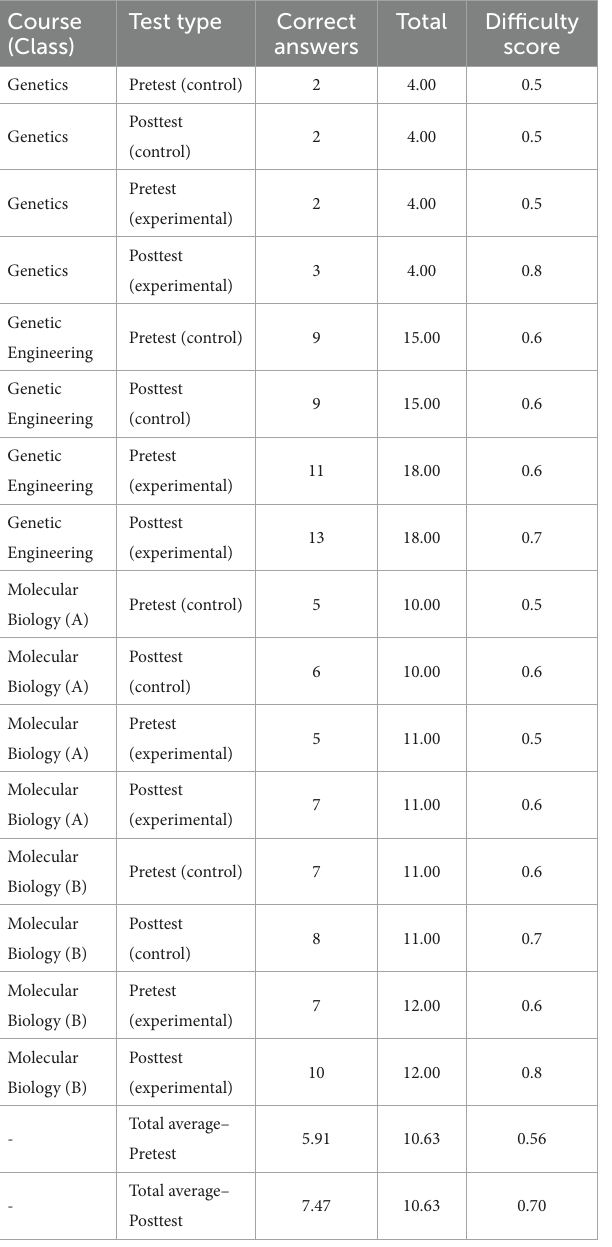
TABLE 2 Difficulty analysis of the questionnaires used to evaluate the four different classes.